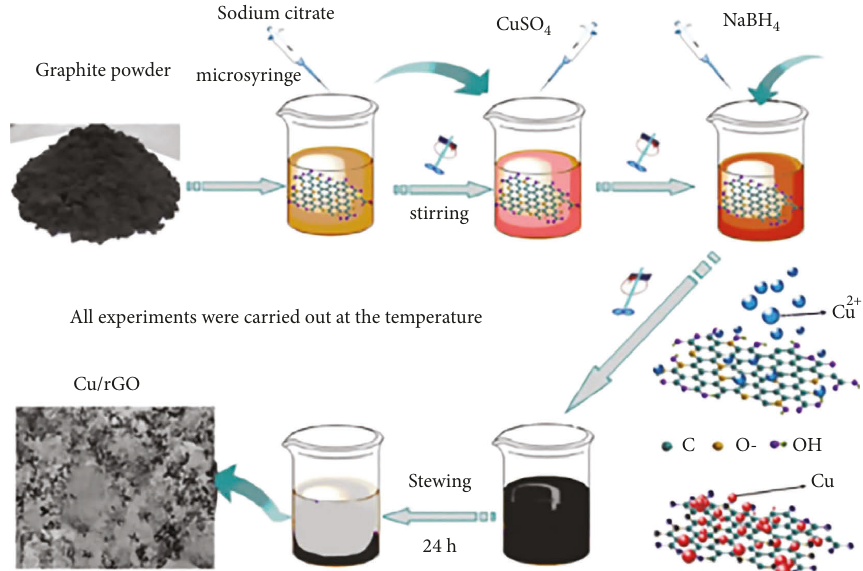
Figure 1: Schematic of the experimental setup and the growth model for